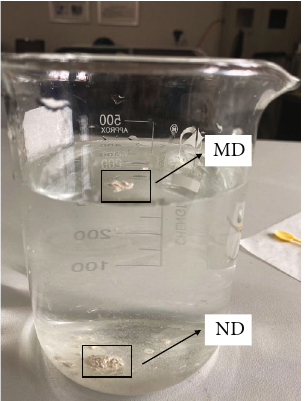
Figure 1: Hydrostatic separation experiment of MD and